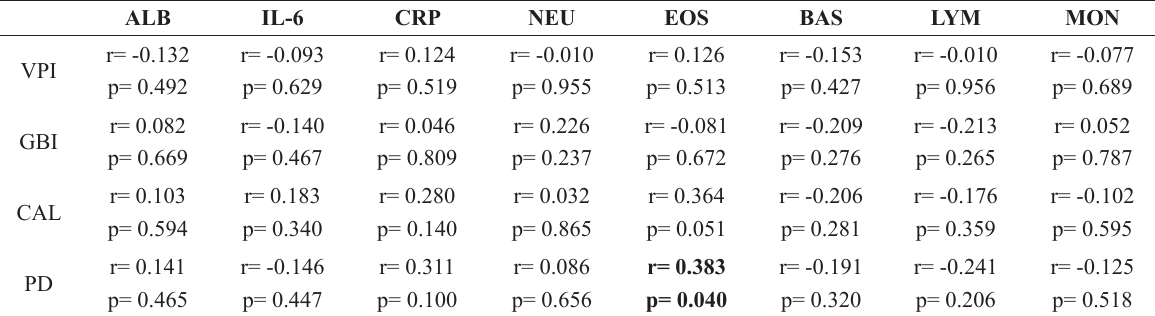
Correlation of variables changes (Δ) between periodontal outcomes and serum biomarkers after periodontal therapy in the control group.